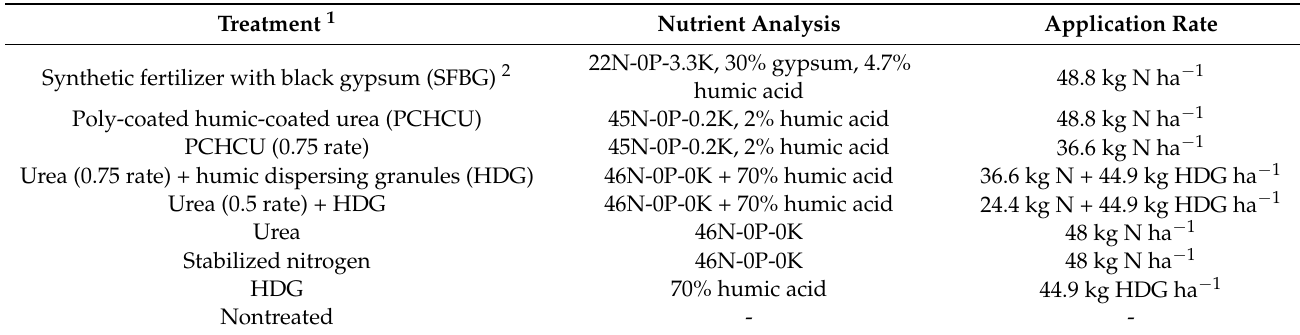
Table 2. Fertilizer treatments, nutrient analysis, and application